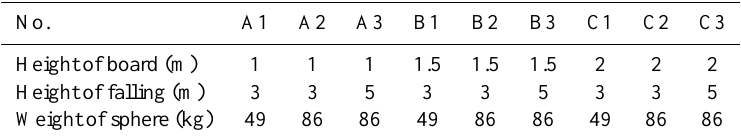
Table 1. Conditions of the experiments.